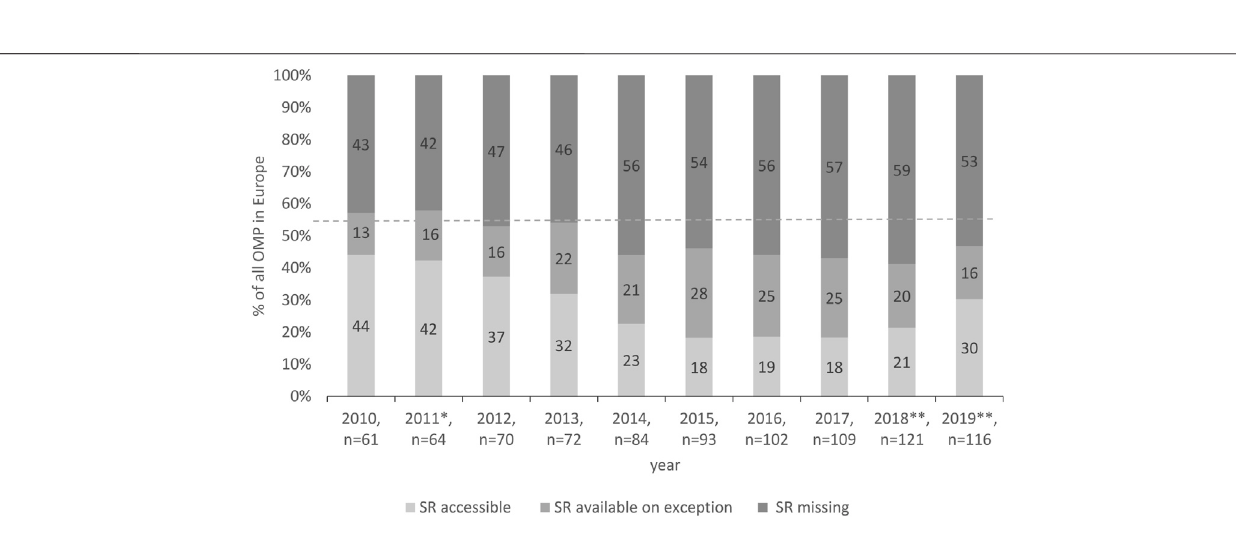
Frontiers in Pharmacology |